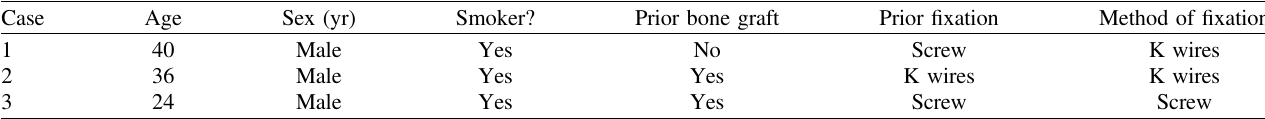
Table 1. Preoperative and postoperative characteristics of patients in whom scaphoid nonunion failed to unite after mfc